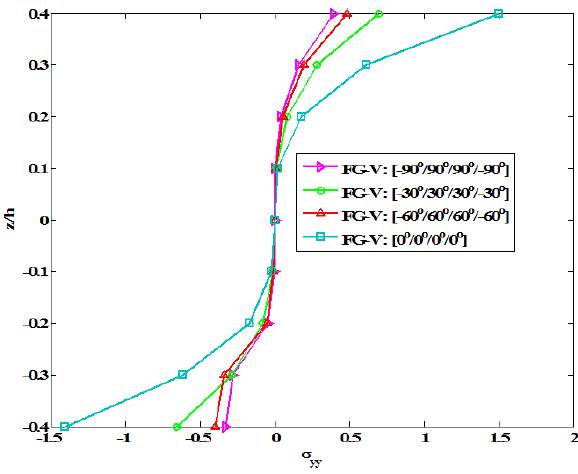
Figure 9: The non-dimensional stress σ yy for angle–ply [- θ / θ / θ /- θ ] UD plate with different lamination scheme